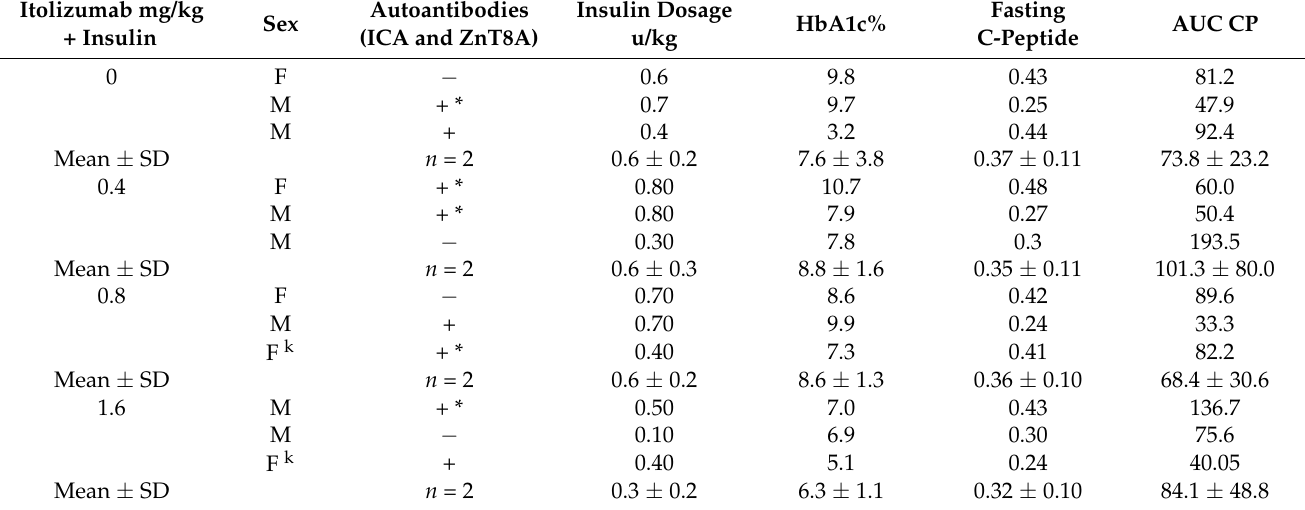
Table 2. Individual information of the participants enrolled in the trial by groups (placebo and treatment groups) at